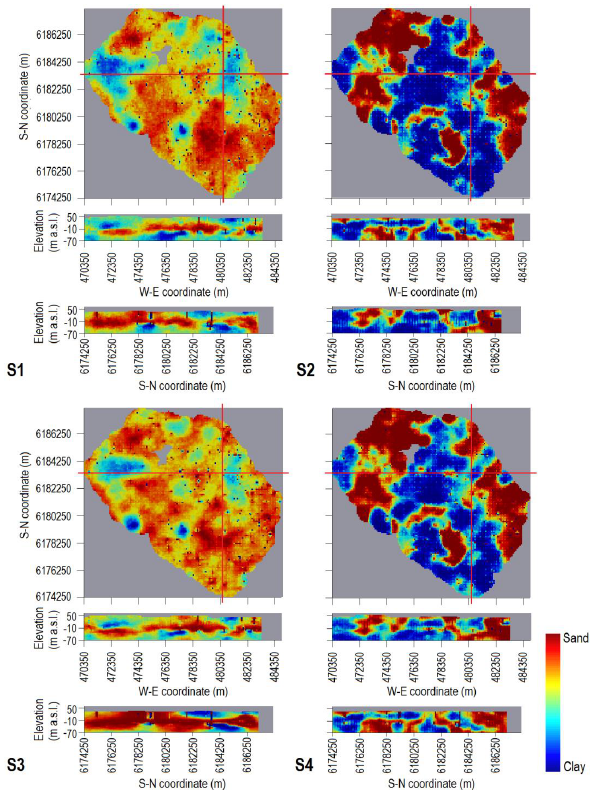
Figure 13. E-type estimation maps generated from 50 realizations Figure 13: E-type estimation maps generated from 50 realizations of the geology of each 2 of the geology of each scenario. The cells where the boreholes are scenario. The cells where the boreholes are located have the deepest colours. The horizontal 3 located have the deepest colours. The horizontal plane is taken at plane is taken at 10 m a.s.l.. 4 10ma.s.l.